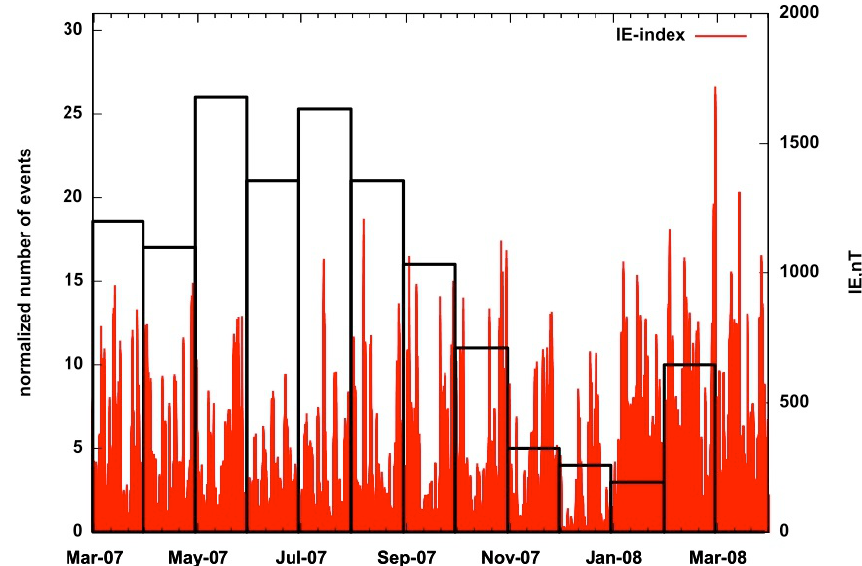
Fig. 18. The IE-index during the IPY-run and the normalised AGW-TID occurrence frequency (black bars; same data as in Fig. 10).